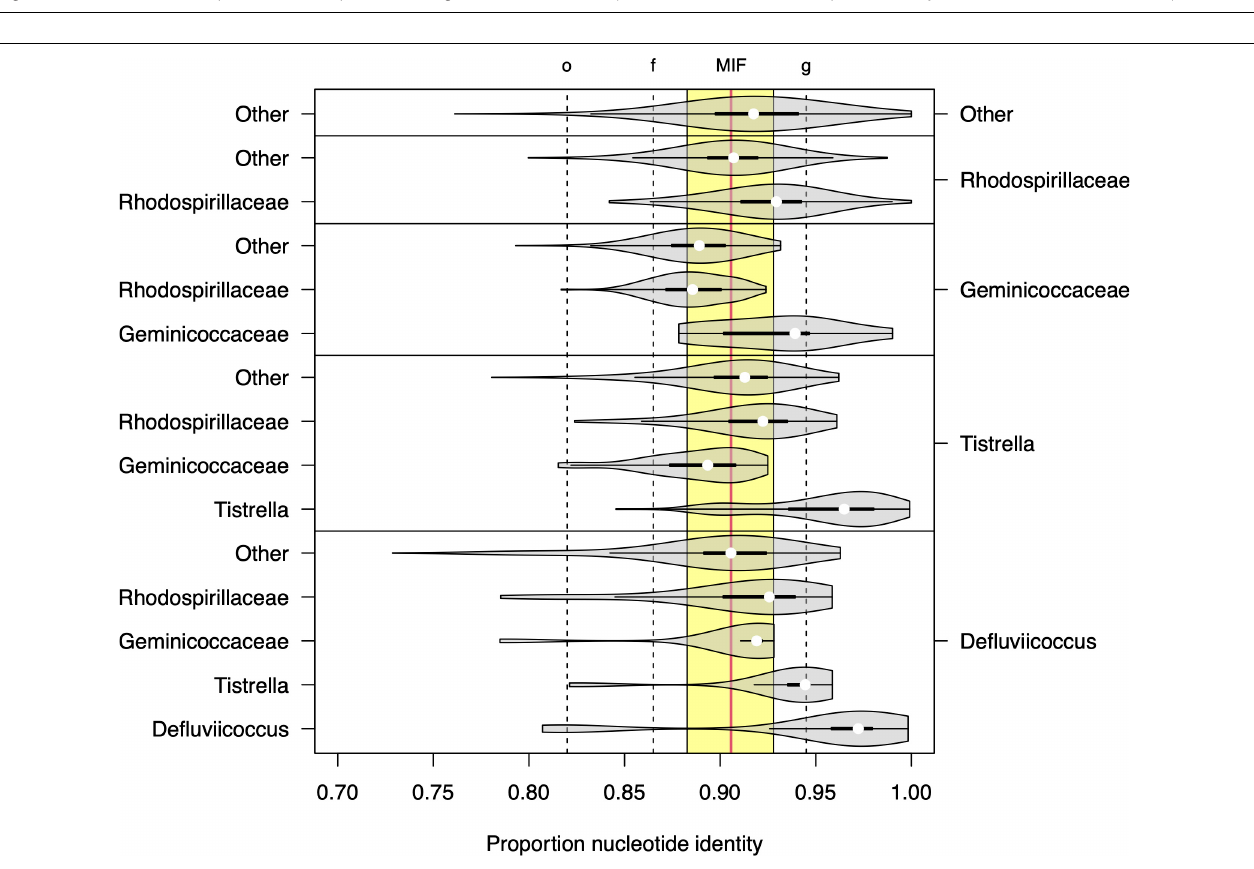
FIGURE 4 | Whole genome phylogenetic structure of members of the genus Defluviicoccus , based on genomes listed in Table 1 and closely related draft and reference genomes. The Defluviicoccus specific cluster is shown here and the full tree is provided as Supplementary Figure 3 . Note that the Slaby bin 129 genomes assumed a distal position with respect to this region and is not shown (see Section “Methods: Comparative Analysis of Defluviicoccus Genomes”).